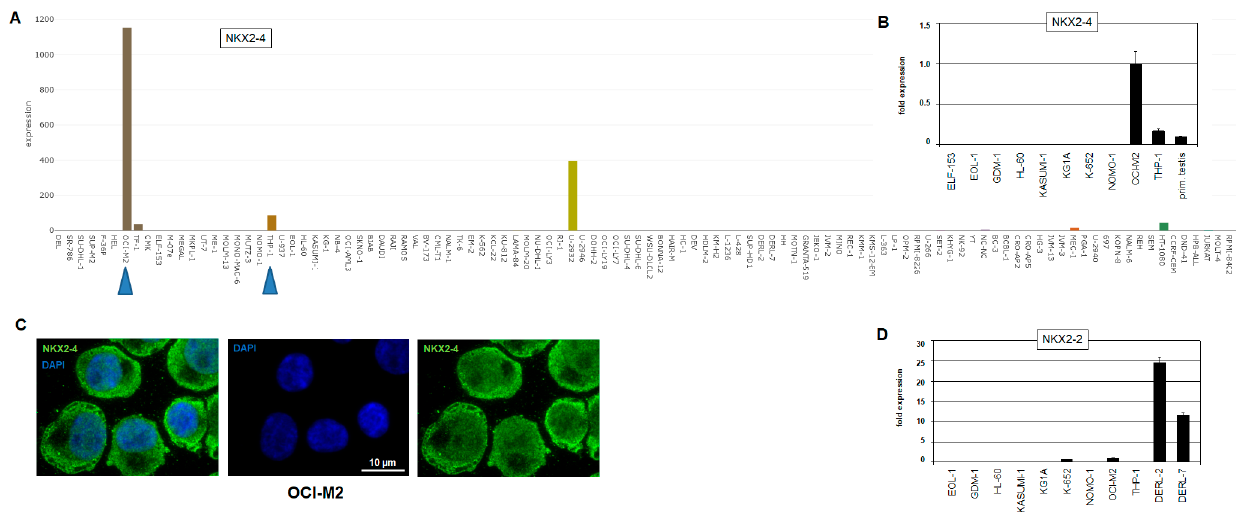
Figure 1. NKX2-4 expression in hematopoietic cell lines. ( A ) LL-100 RNA-seq data show enhanced expression of NKL homeobox gene NKX2-4 in AML cell line OCI-M2, while THP-1 expresses low levels (blue arrow heads). Gene expression values are given as DESeq2 normalized count data. ( B ) RQ-PCR analysis confirms high transcript levels in OCI-M2, while THP-1 and primary testis express lower levels. The expression level in OCI-M2 was set as 1. ( C ) Immunostaining of NKX2-4 protein in OCI-M2 cells, showing signals in both cytoplasm and nucleus (green). DAPI was used as nuclear counterstain (blue). ( D ) RQ-PCR analysis of NKX2-2 in selected AML cell lines and T-cell lymphoma cell lines DERL-2 and DERL-7 shows elevated transcript levels in the latter, while THP-1 tested negative. The expression level in OCI-M2 was set as 1.